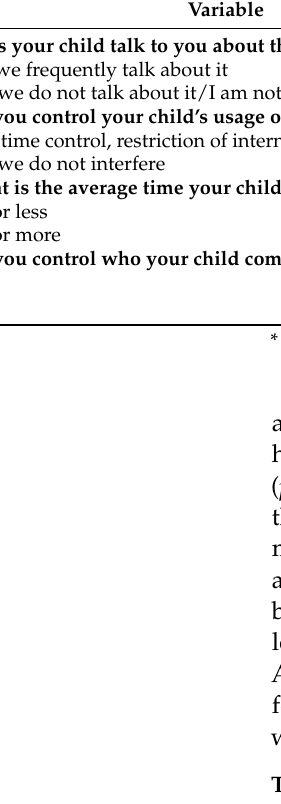
Table 3. Distribution of the respondents by control measures taken and awareness of threats. Variable Low Awareness of Threats High Awareness of Threats p -Value